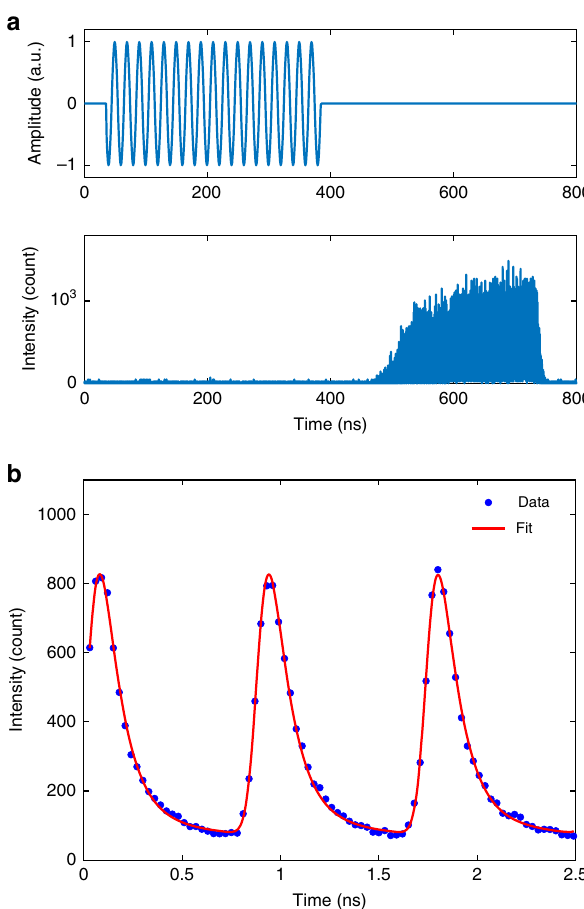
Fig. 2 Time-resolved measurement of the SAW-driven EL. a A 350 ns- long pulsed RF signal (top, shown at a low frequency for clarity) is applied to the IDT to create a pulsed SAW. The SAW-driven EL signal (bottom) is delayed by roughly 400ns owing to propagation of the SAW from the IDT to the n-i-p junction. b Averaged SAW-driven EL and the best fi t using H ( t ) (see Supplementary Note 2).